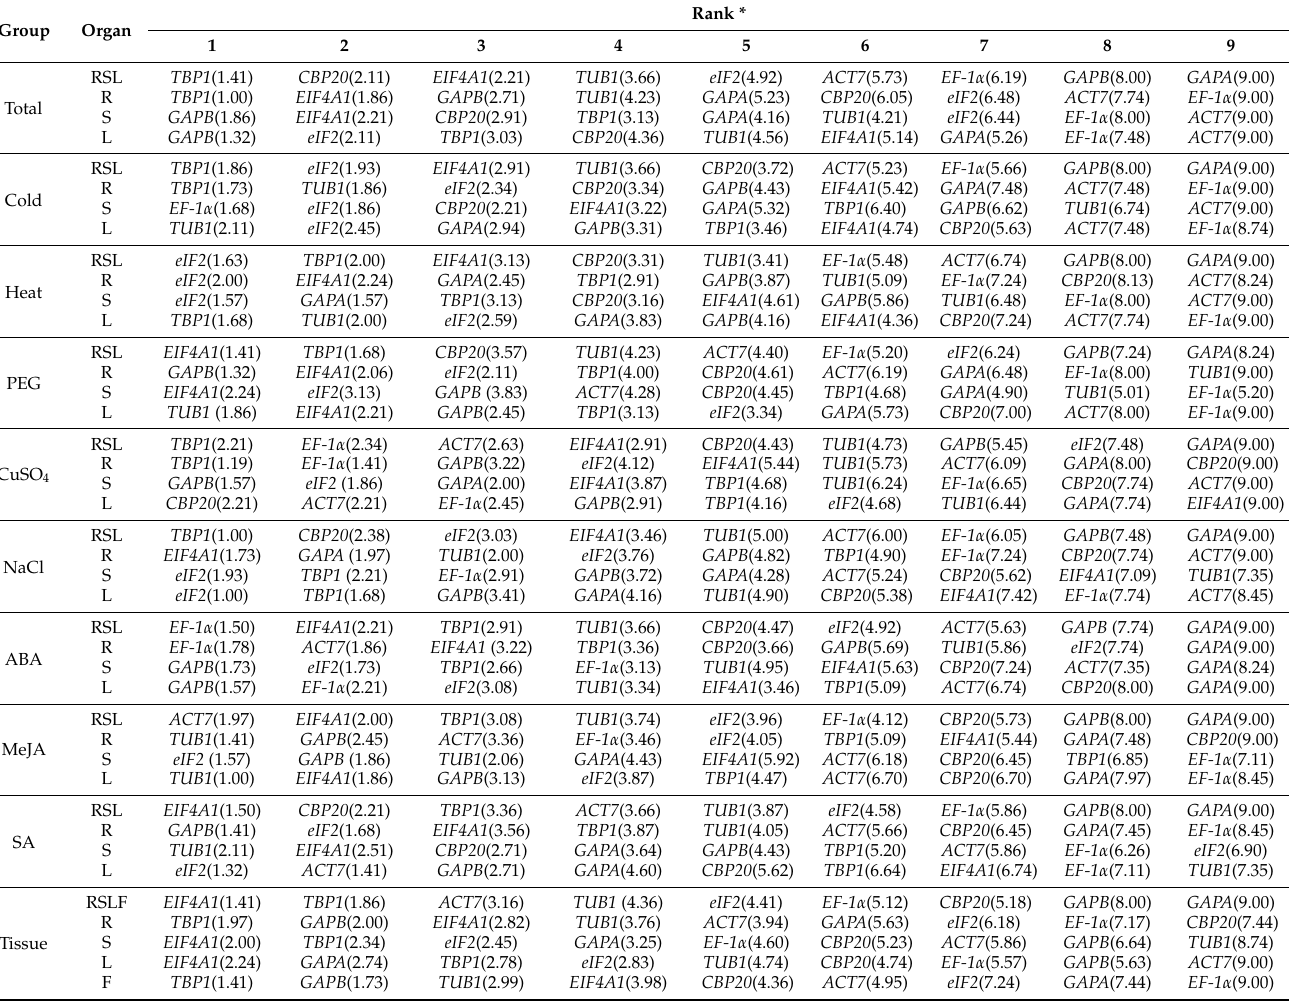
Table 3. A comprehensive ranking of nine candidate reference genes integrated by